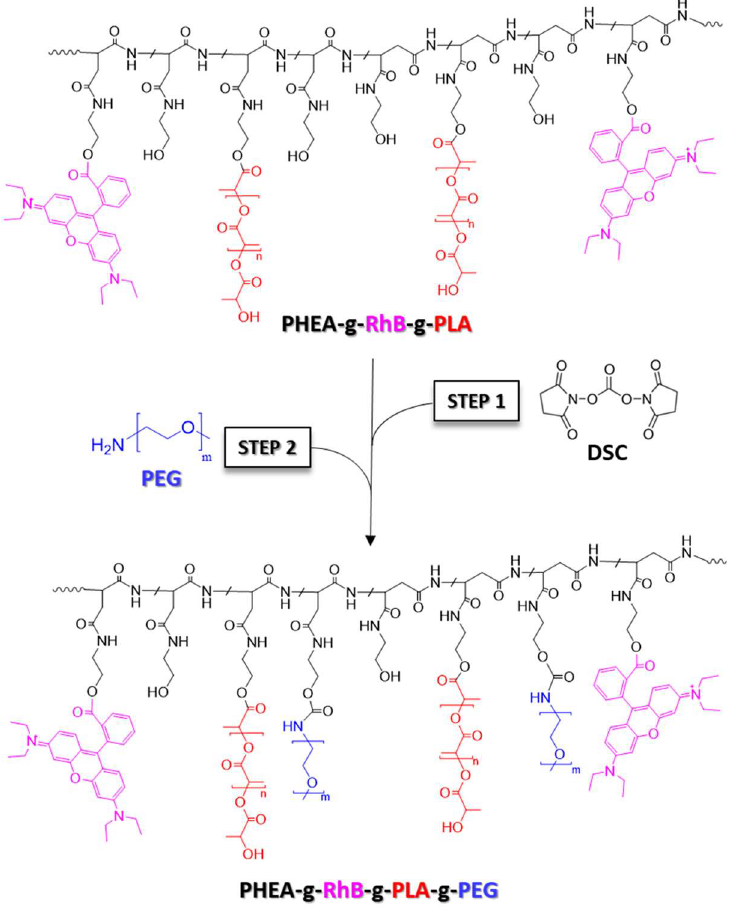
Scheme 1. Synthetic procedure and chemical structure of PHEA-g-RhB-g-PLA-g-PEG. Step 1: DSC,